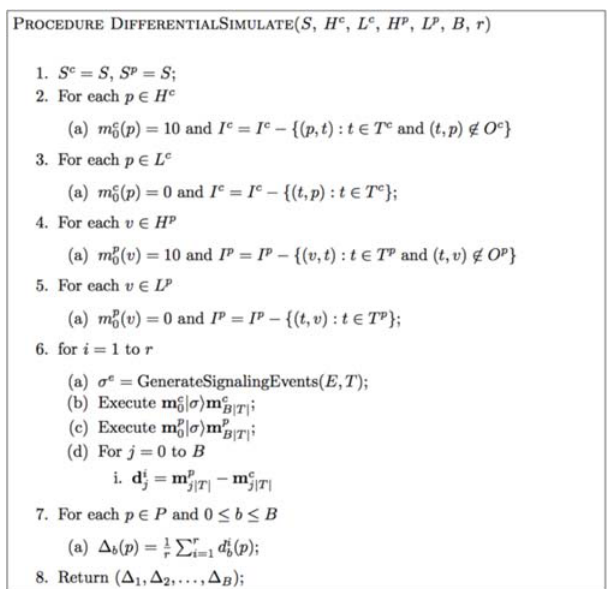
Figure 8. The Algorithm for Predicting the Effect on Signal Propagation of a Targeted Manipulation. The algorithm for predicting the effect on signal propagation of a targeted manipulation on signaling network with connectivity G. The ‘c’ and ‘p’ superscripts are used to denote parameters in the control and perturbed versions, respectively, of the